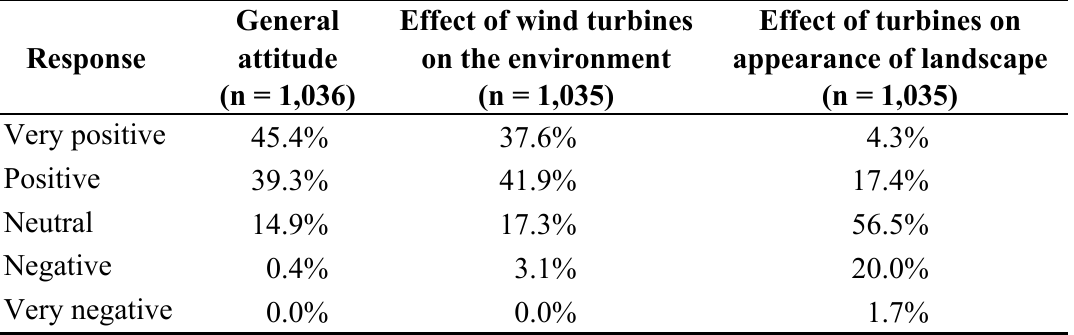
Table 4. Attitude toward and perceived effects of wind